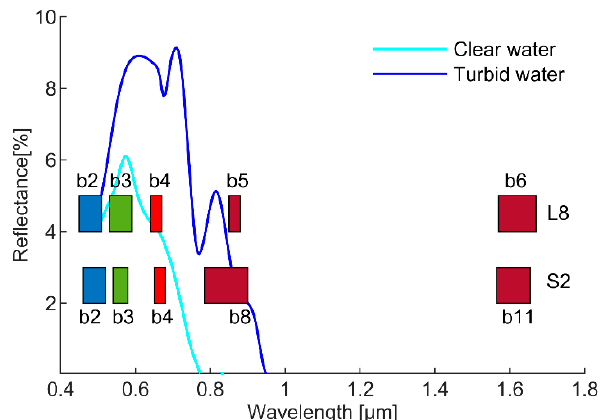
Figure 2. Spectral reflectance of clear and turbid water compared to L8 and S2 acquired bands.